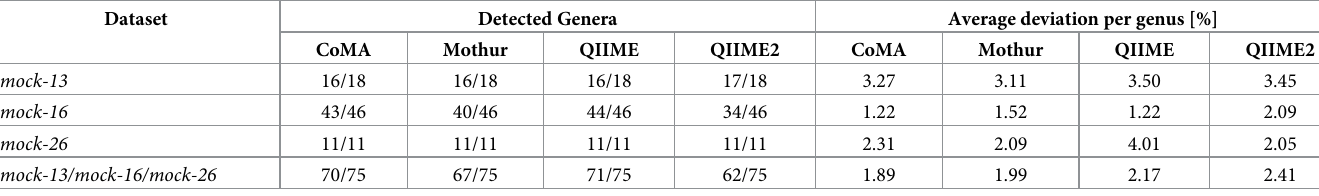
genera (16S rRNA); mock-26 : 11 fungal genera